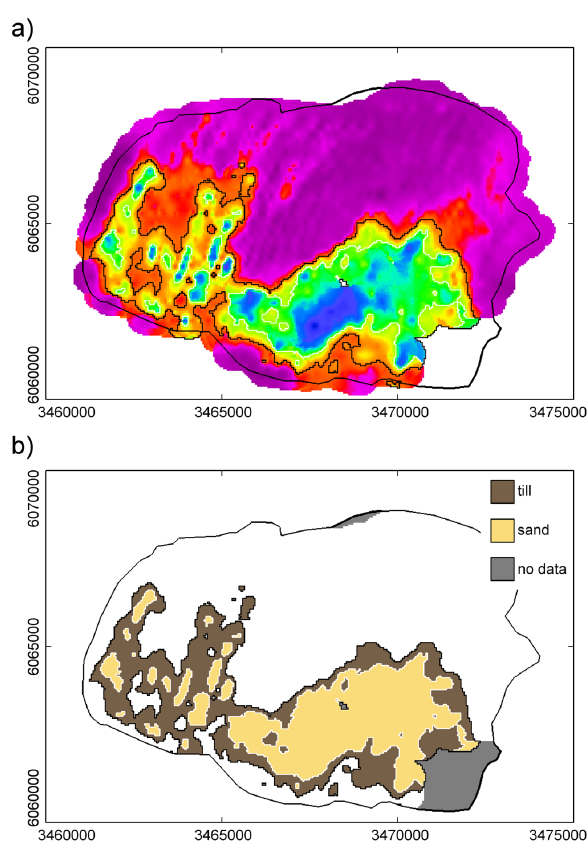
Fig. 9. Depth slice of (a) SkyTEM mean resistivity between − 40 to − 50mm.s.l. (for colorscale, see Fig. 4d); and (b) lithological interpretation from petrophysical characterization (boundary of till to saline water saturated area is defined by 20 (cid:127) m, boundary of till/sand is set to 50 (cid:127) m). Hence, blue–green colours indicate fresh groundwater, and purple–red colours indicate salt